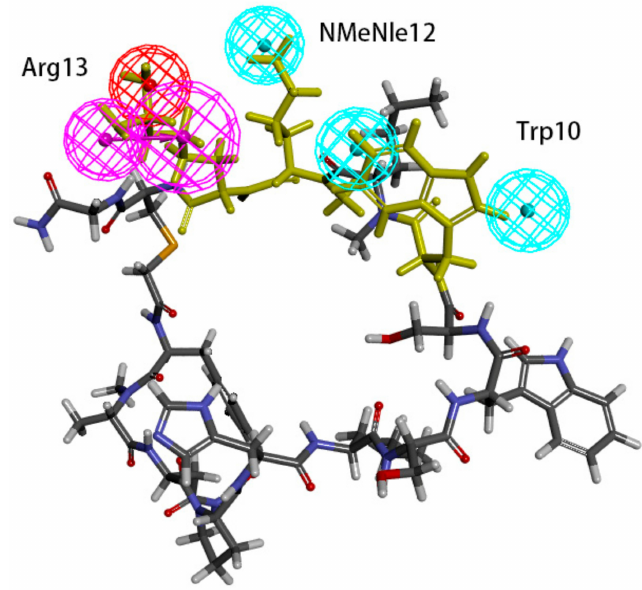
Figure 10. Superposition between Hypo 1B and peptide-57. As the figure shows, the positive ionizable point is red, the hydrophobic point is blue, and the hydrogen bond donor is purple. The labelled residues are